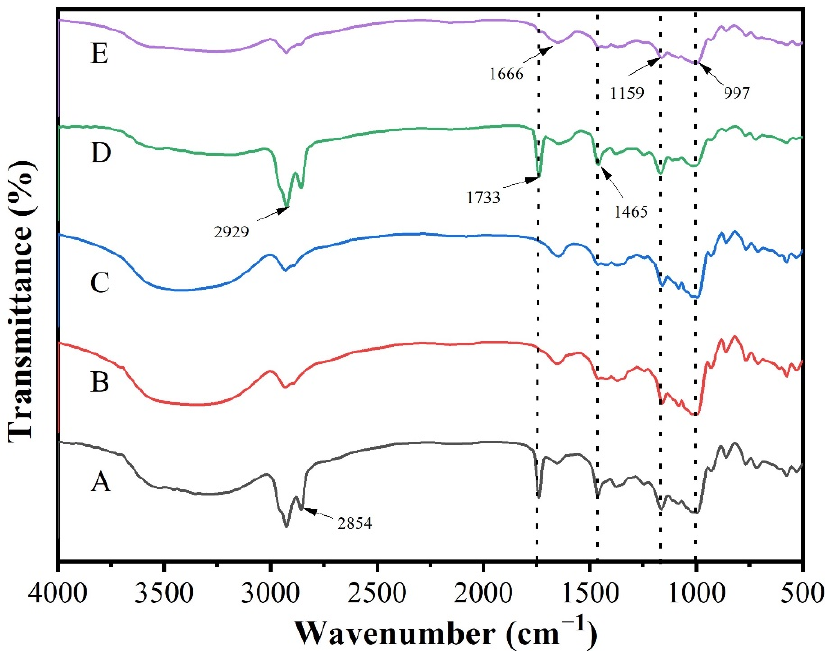
Figure 3. FTIR spectra of ( A ) PS/SOEO; ( B ) modified starch; ( C ) natural starch; ( D ) SOEO microcapsules; and ( E ) microcapsules without SOEO.